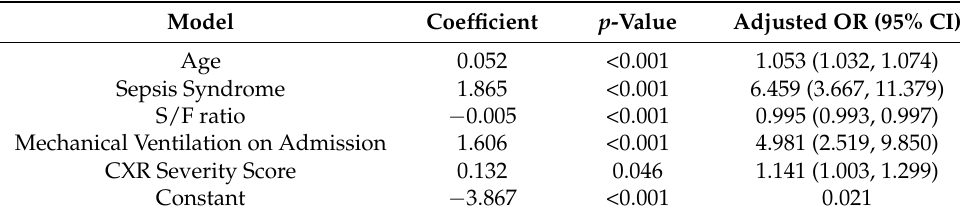
Table 4. Predictive model developed in the derivation dataset ( N = 439).